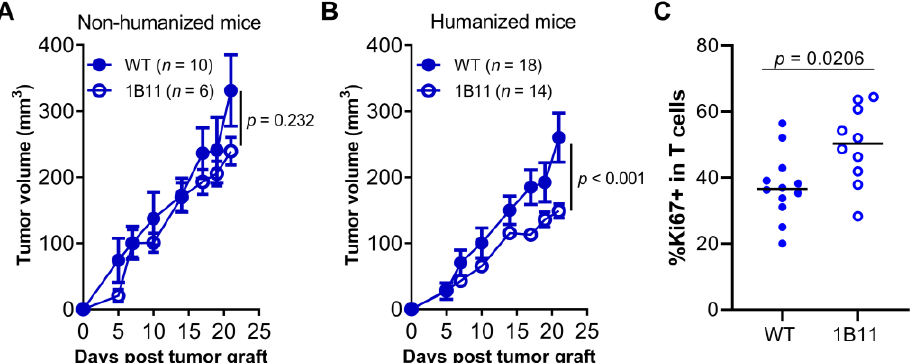
Figure 6. HVEM was an immune checkpoint during anti-tumor T cell immune response in humanized mice. Growth of the indicated PC3 cell lines (WT or 1B11) in non-humanized ( A ) or PBMC-humanized mice ( B ). Curves are the mean tumor volume ( ± SEM) in the indicated number of mice. Data are cumulative of at least two experiments. The p -value on the graphs tests the null hypothesis that the slopes are equal using a linear regression model. ( C ) Frequencies of Ki67 + in CD4 + and CD8 + T cells in PC3 WT or 1B11 tumor at day 21 post-humanization from one experiment with 6 and 5 mice, respectively. The p -values are from a Mann–Whitney t -test.